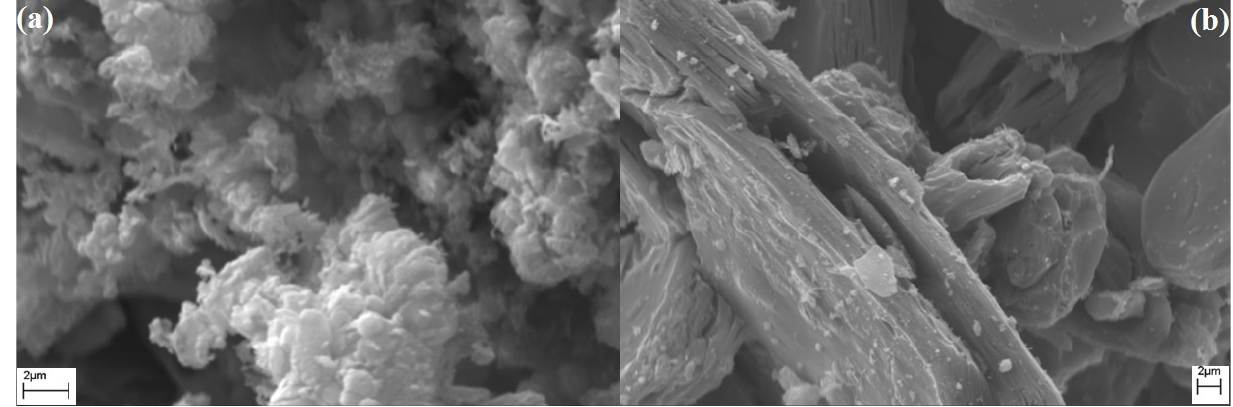
Figure 13. SEM images of the decomposition products form from compound 1 at 500 °C under nitrogen ( a ) and air ( b ). Table 3. The specific surface area (m 2 ·g − 1 ) of the thermal decomposition intermediates and end − products that formed at different temperatures from compound 1 in N 2 and air.